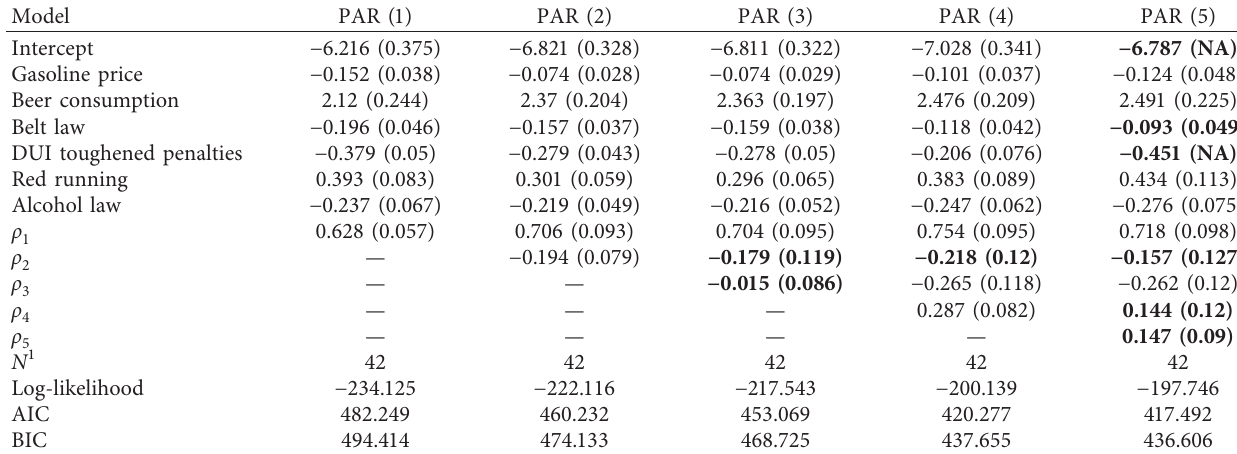
Table 2: Modelling results for different orders of PAR models.